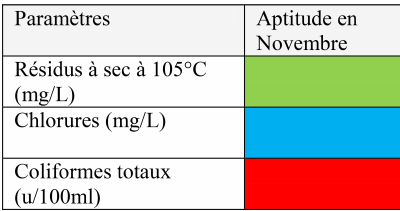
Tableau 5. Aptitude de l’eau à l’irrigation en novembre.